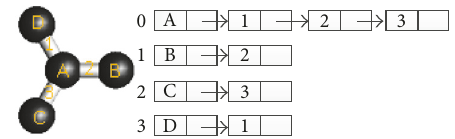
Figure 2: Molecular structure representation based on adjacency list.